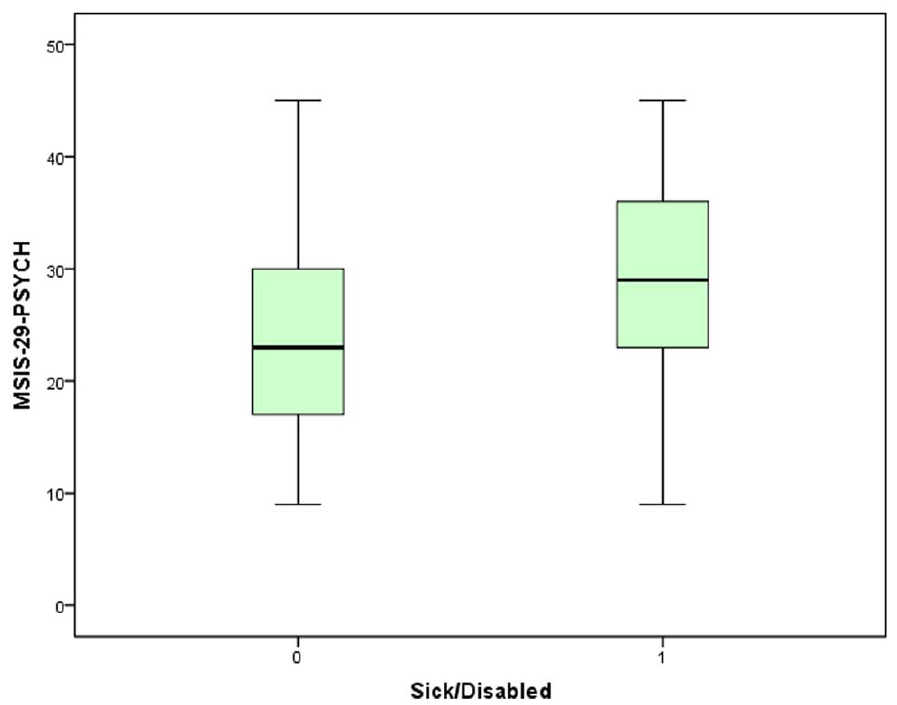
Figure 5. The MSIS-29-PSYCH scores for people of workforce age. The scores of people who report they are sick/disabled (=1) were compared with those who are not sick/disabled